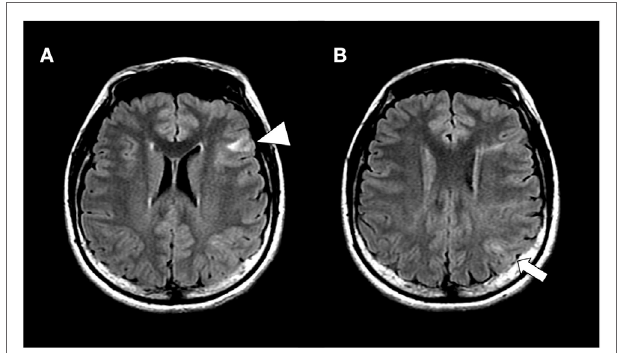
FIgURe 1 | Hippocampal slices of fluid attenuated inversion recovery magnetic resonance imaging at lateral ventricles level (a) and next slice above A (B) . The patient showed multiple cortical tubers on bilateral hemispheres, including in the inferior frontal gyrus (arrow head) and inferior parietal lobule